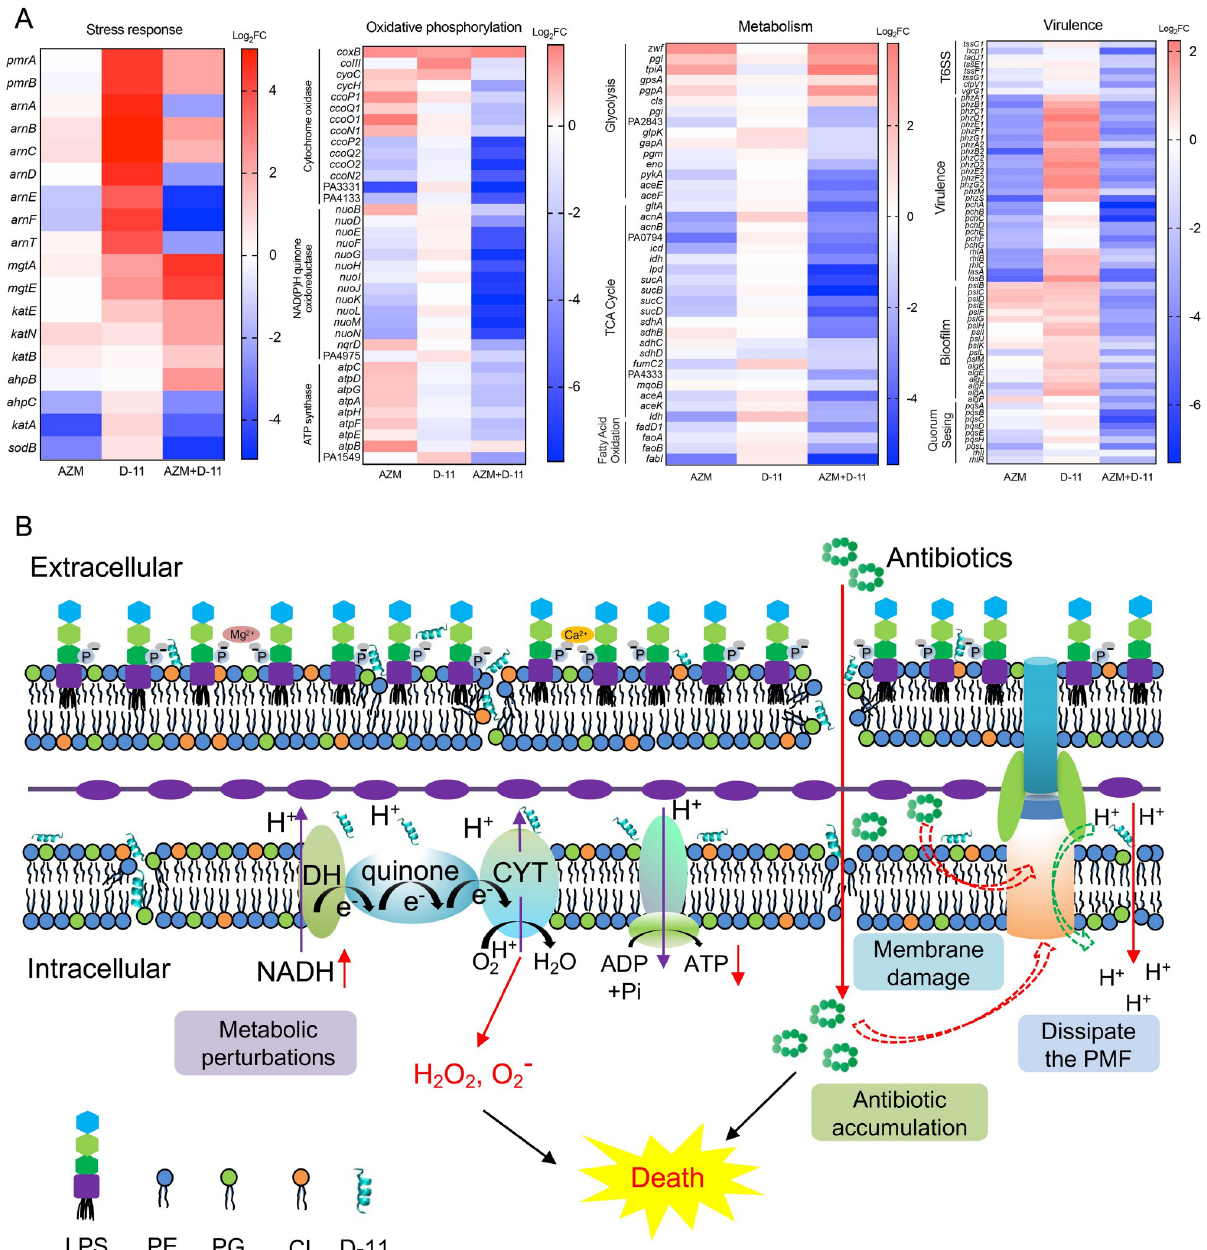
Fig 4. Transcriptome analysis and proposed synergy action model. ( A ) The effect of D-11 alone, azithromycin alone or the combination over the expression of several genes involved in stress response, oxidative phosphorylation, metabolism and virulence. AZM, 8 μ M azithromycin treatment alone; D-11, 4 μ M D-11 treatment alone; AZM + D-11, the combination of azithromycin and D-11 treatment. ( B ) Proposed action mechanism for the synergy of D-11 in combination with antibiotics. D-11 restores the susceptibility of P . aeruginosa to antibiotics through membrane-mediated mechanisms by interacting with LPS, CL and PG. These reactions trigger membrane depolarization and induce membrane dysfunction, further resulting in metabolic perturbations and ROS accumulation. In addition, more antibiotics rapidly accumulate inside bacteria due to the increased membrane permeability and dysfunction of efflux pumps mediated by the dissipation of membrane potential. The accumulation of ROS and antibiotics working together resulted in the death of cells.